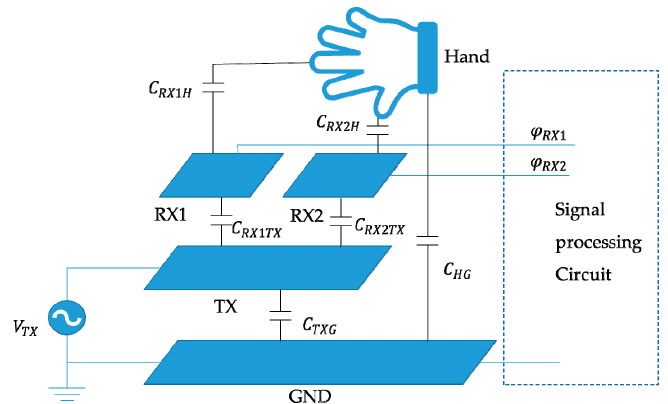
Figure 1. The equivalent circuit model of the electric-field detection system.